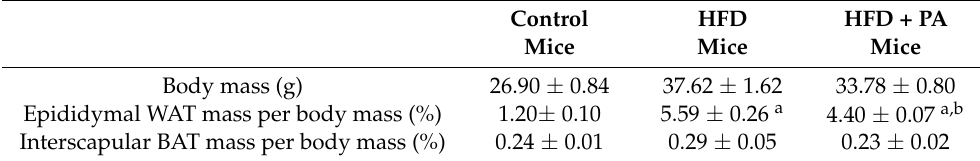
Table 2. Levels of body mass, WAT and BAT mass of control, HFD, and HFD + PA mice.